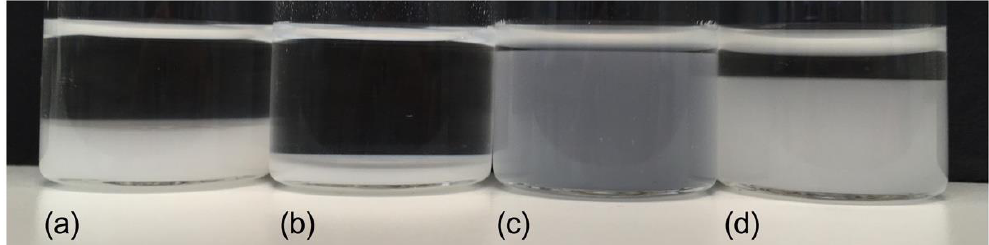
Figure 2. Swelling behavior of CCS and SSG in water and ethanol/water 1/1 ( v/v ). ( a ) CCS in ethanol/water 1/1 ( v/v ); ( b ) SSG in ethanol/water 1/1 ( v/v ); ( c ) CCS in water; ( d ) SSG in water.